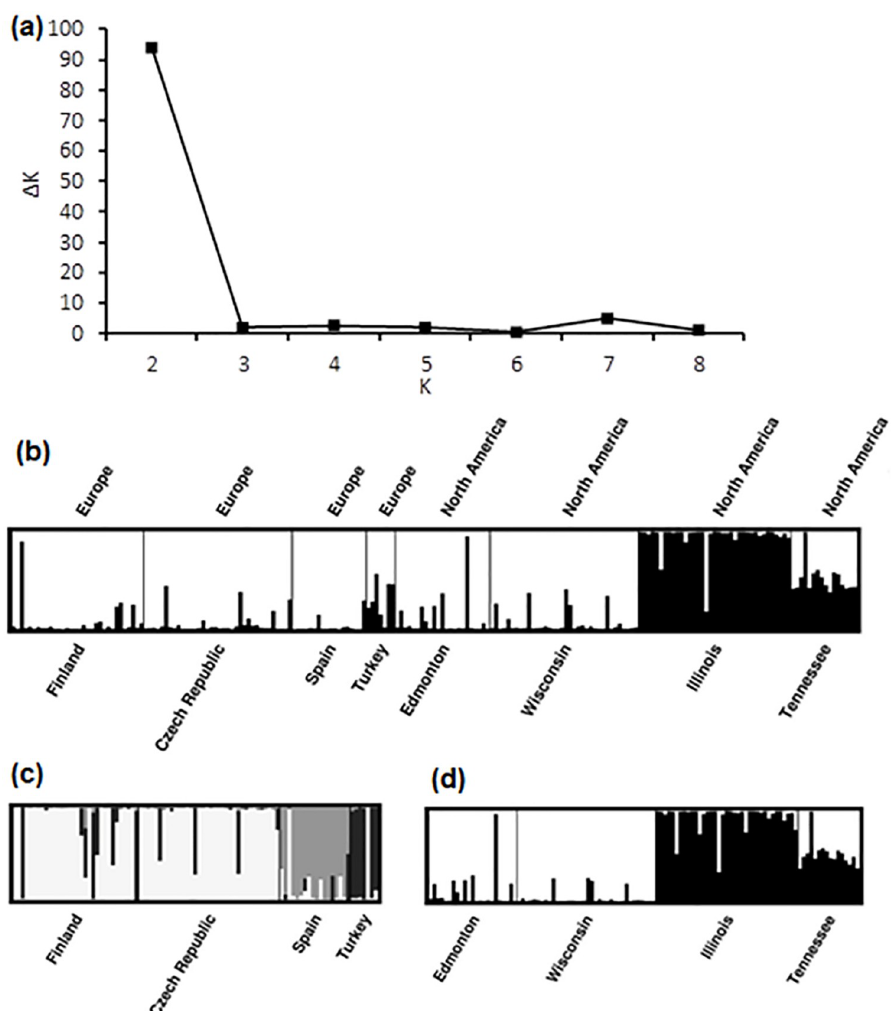
Fig 6. Genetic similarity of Lythrum salicaria individuals germinated from seeds collected along two latitudinal gradients in Eurasia and North America as determined using the program STRUCTURE: (a) a plot of the range of possible genetically distinct L . salicaria clusters, K , against Δ K , a model choice criterion for selection of the most likely K ; (b); probabilistic assignment of Lythrum salicaria samples from populations along two latitudinal gradients to one of two genetically distinct clusters (white vs. black bars); (c) sub-comparisons for Eurasian populations ( K = 3) and (d) North American populations ( K =